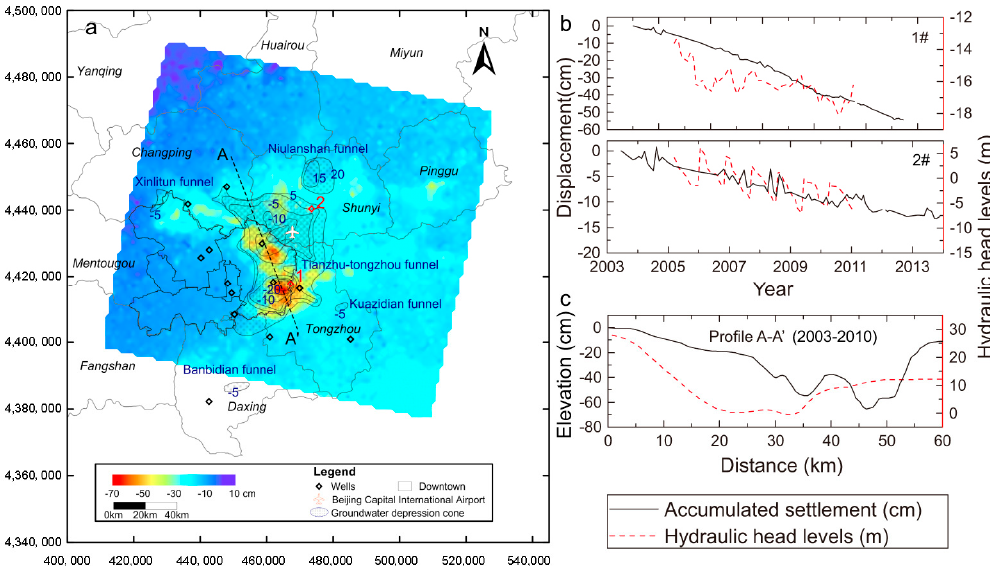
Figure 6. Spatial and temporal characteristics of land subsidence and hydraulic head levels: ( a ) InSAR-measured accumulated subsidence between June 2003 and August 2010 with the average hydraulic head level during the same period; and ( b ) monitoring results for confined hydraulic head level and InSAR-measured subsidence for selected wells. The illustration at bottom details the profile A–A’ in Figure 6a.